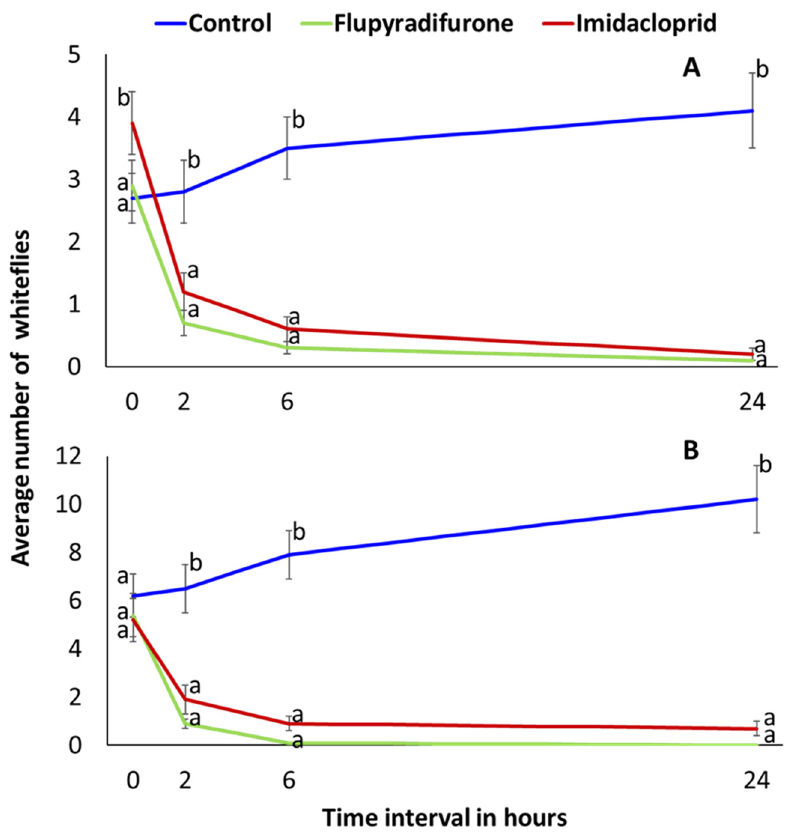
Figure 4. Insecticide (flupyradifurone and imidacloprid) knock-down effect on whitefly counts at 2 h, 6 h and 24 h after spraying at 3 weeks after planting (WAP) ( A ) and 6 WAP ( B ) (Means ± SE). Means with same letter within time interval are not significantly different ( p < 0.05, Tukey–Kramer). Table 3. Cassava mosaic disease (CMD) percentage incidence for Vuli 2017 (Means ± SE) Z